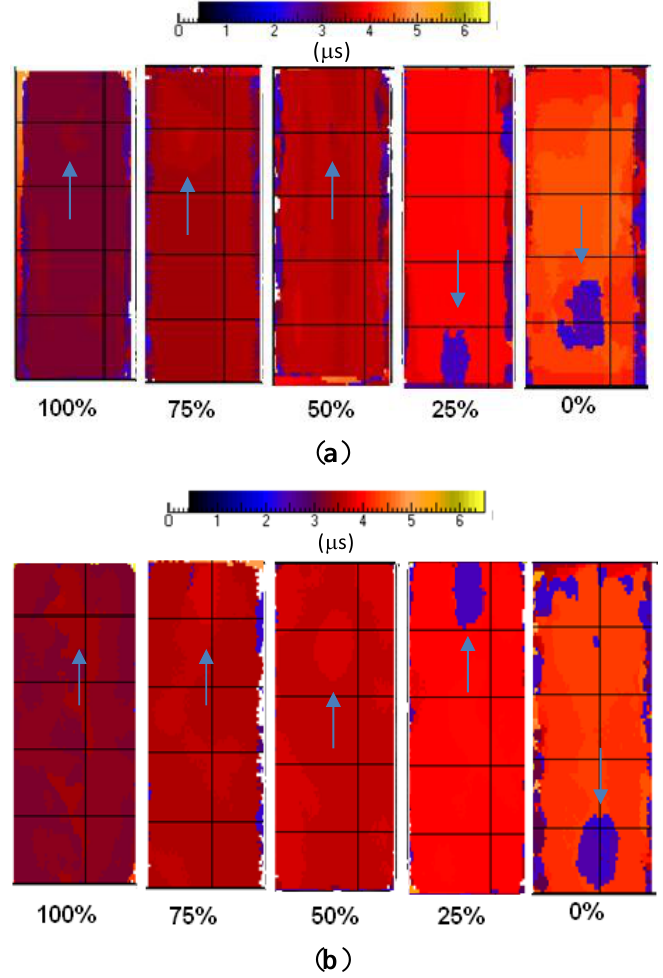
Figure 5. Time-of-flight (ToF) c-scan for different P coupons. An arrow indicates the position of the Kapton disk in each map.